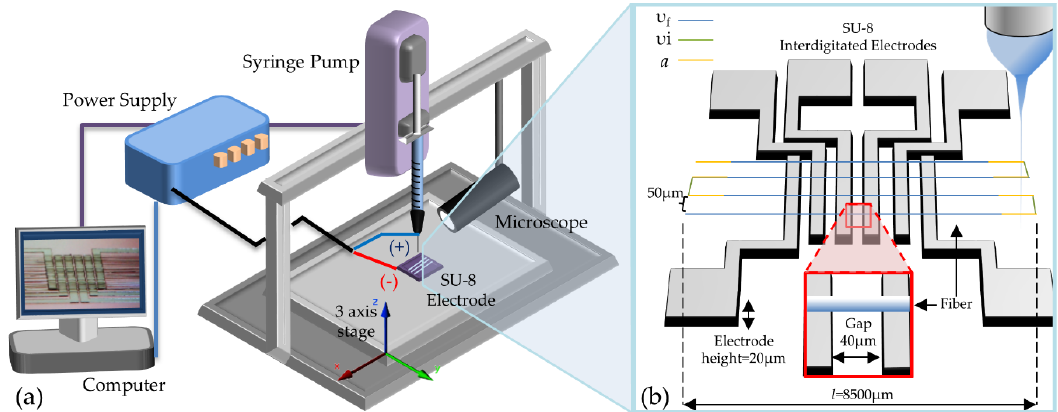
Figure 2. ( a ) Schematic of Contact Low-Voltage NFES experimental setup and ( b ) patterned deposition of fibers on SU-8 electrodes; velocities of fabrication, v f in blue, inter-fabrication, v i in green, and the acceleration, a in yellow, are schematically represented.